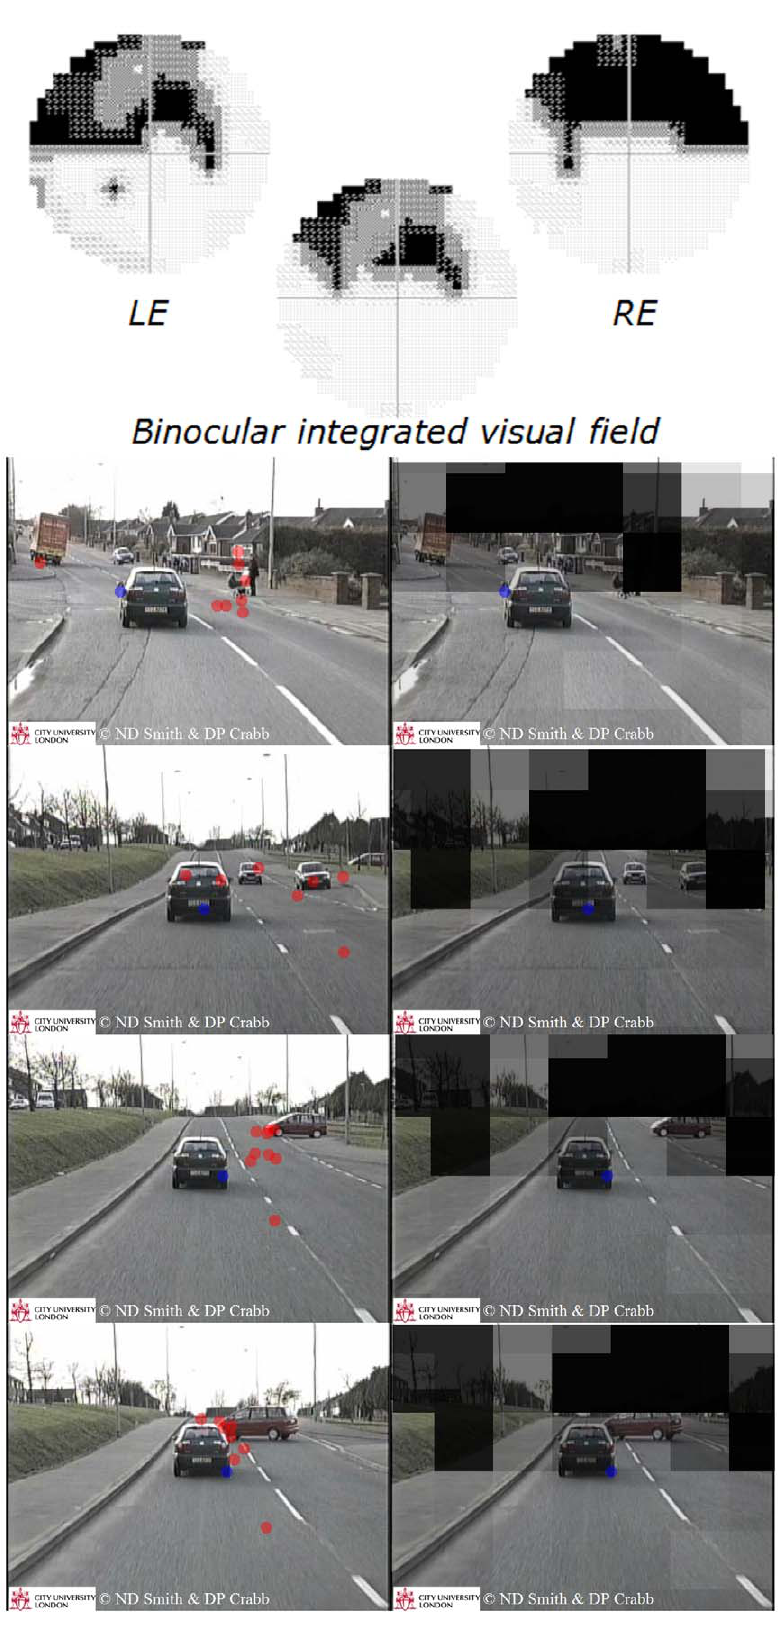
Figure 3. Visual fields, dynamic ‘point of regard’ and HPT films – example. HFA grayscales for monocular (30-2) and binocular integrated visual fields for one of the participants with bilateral glaucoma. The integrated visual field is scaled and superimposed on the point of regard HPT film